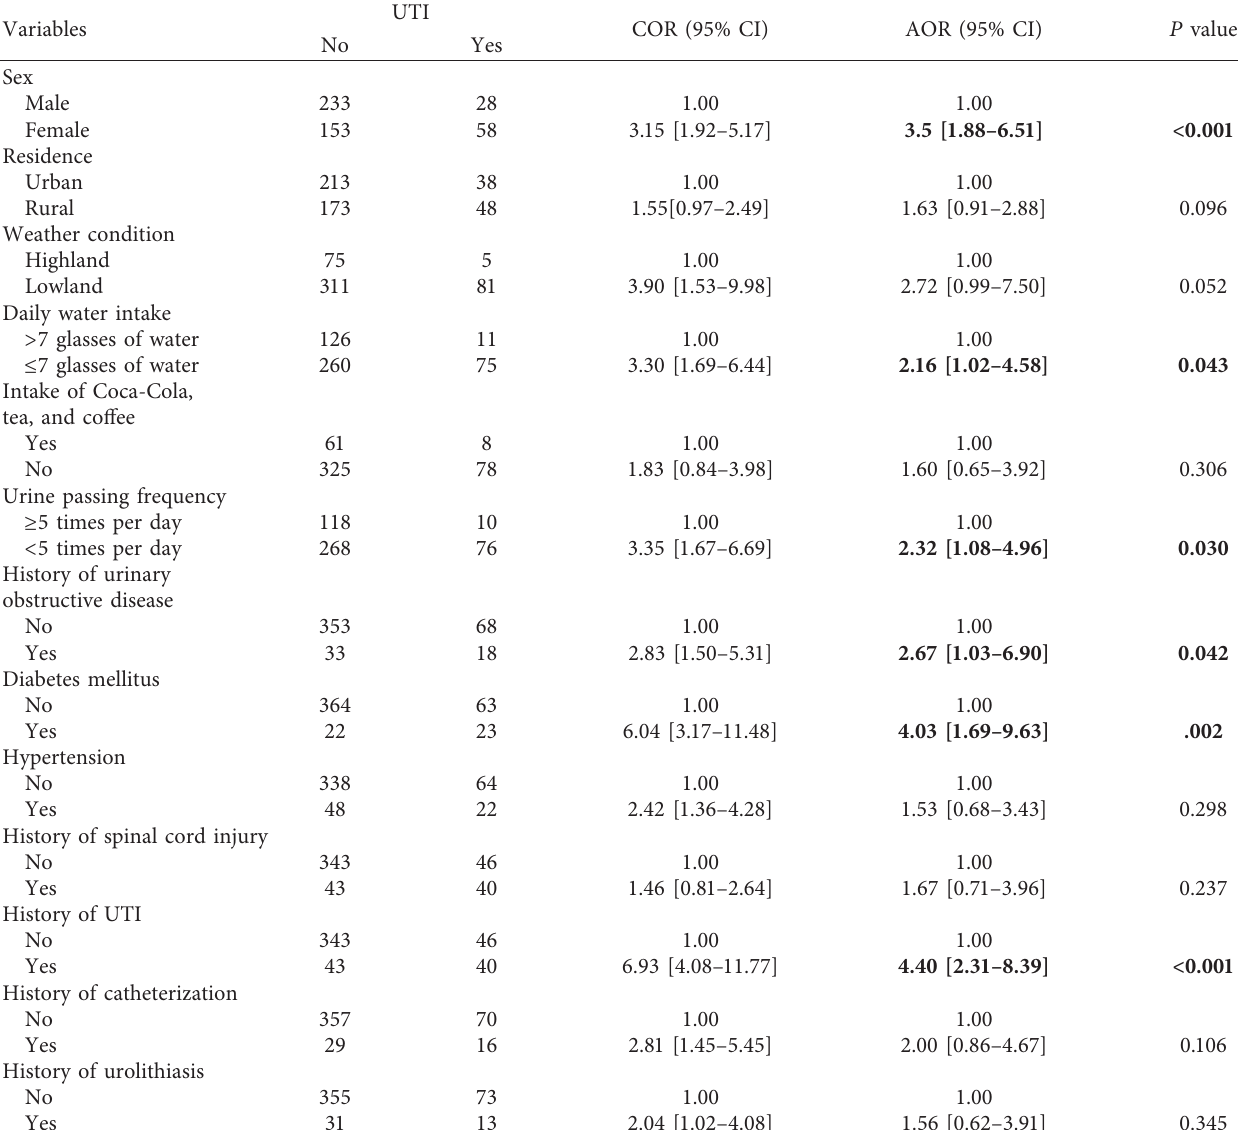
Table 4: Regression analysis of associated factors with urinary tract infection among adult patients attending the OPD in Tigray region hospitals, Ethiopia, 2019 ( N �